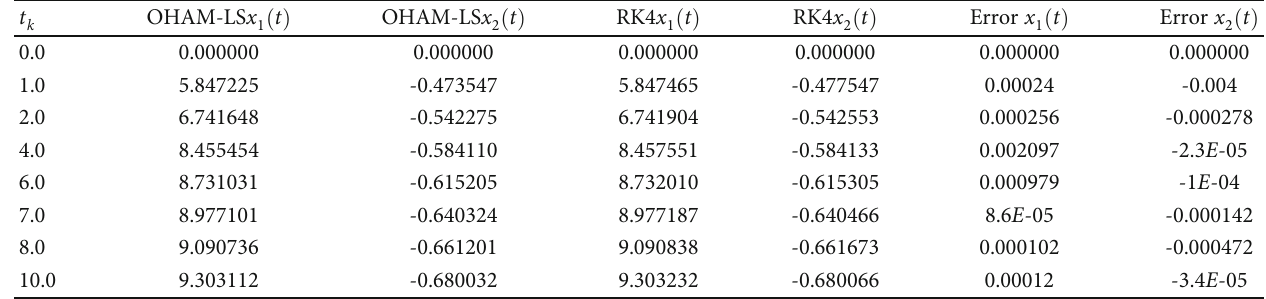
Table 4: Comparison and absolute error between OHAM-LS and RK4, α = 1